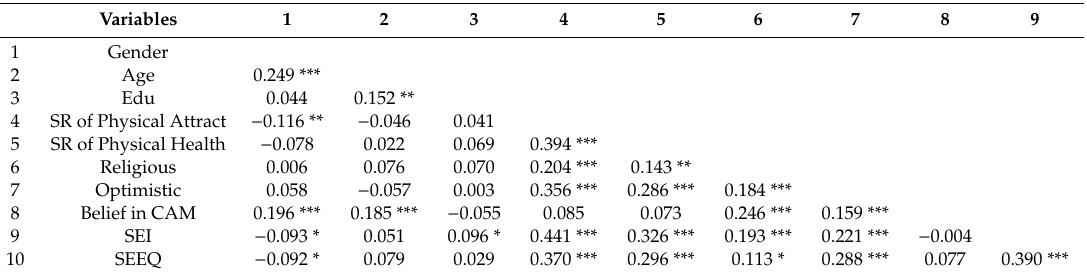
Table 1. Pearson product–moment correlations of variables in the first